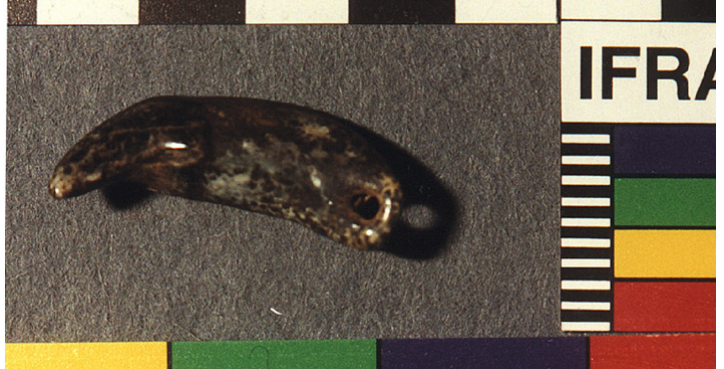
Figure 2. Wolf incisor, drilled at its root, 36 mm long, from a Lower Paleolithic occupation layer in Repolust Cave, Styria,